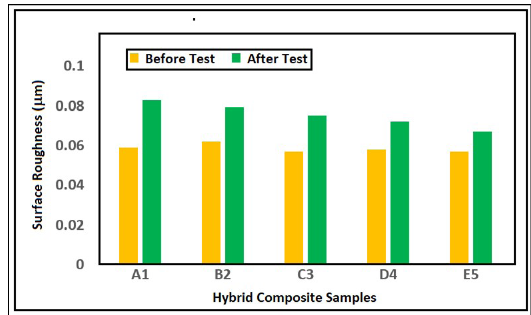
Figure 15. Mean surface roughness of hybrid composite samples before and after wear